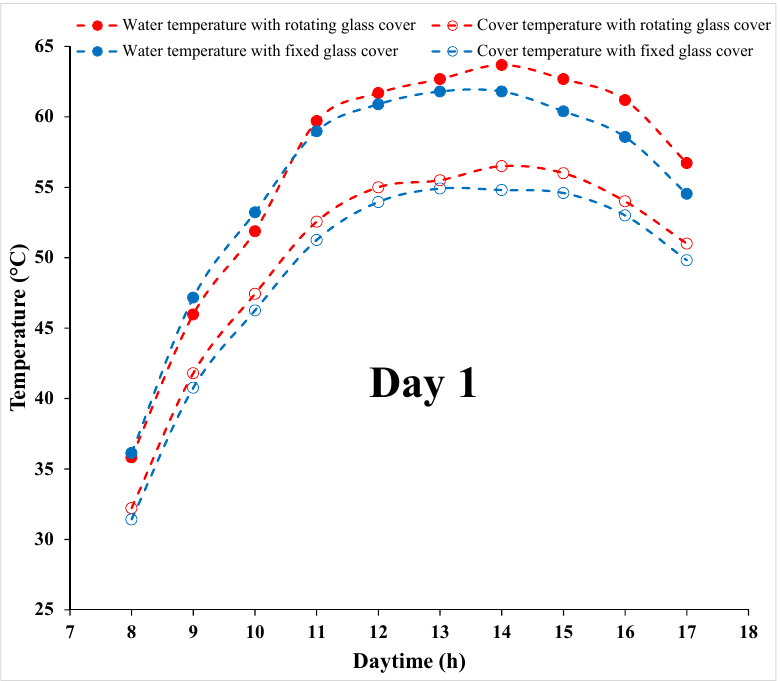
Figure 5. Water and cover temperature on 27 August 2021 (day 1) where the cylindrical cover is fixed or rotates. During experimentation day 1, the cover temperature starts at 31.4 °C and 32.2 °C at 08:00, reaches its maximum of 54.9 °C at 13:00 and 56.5 °C at 14:00, and finally falls to 49.8 °C and 51 °C at 17:00, with an average in the order of 49.1 °C and 50.2 °C, where the cover is fixed and rotating, respectively. Thus, the use of a rotating cover, continuously wiped on the inner surface, permits increasing the cover temperature by 1.1° on average (from 49.1 °C to 50.2 °C) and 1.6° at the maximum (from 54.9 °C to 56.5 °C). The water temperature starts at 36.1 °C and 35.8 °C at 08:00, reaches its maximum of 61.8 °C at 13:00 and 63.7 °C at 14:00, and finally falls to 54.5 °C and 56.7 °C at 17:00, with an average in the order of 55.4 °C and 56.2 °C, where the cover is fixed and rotating, respectively. Thus, the use of a rotating cover, continuously wiped on the inner surface, permits increasing the water temperature by 0.8° on average (from 55.4 °C to 56.2 °C) and 1.9° at the maximum (from 61.8 °C to 63.7 °C).